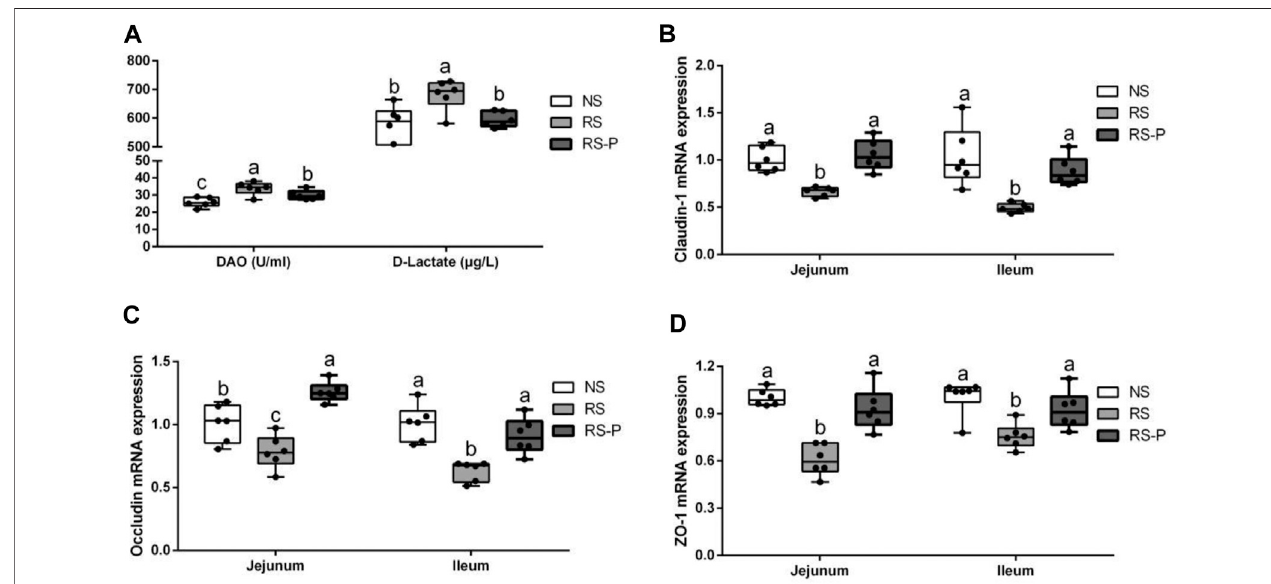
FIGURE10| EffectofL.johnsoniiBS15ongutintegrityandpermeability.Dataarepresented withthemeans ± standarddeviation( n (cid:2) 6).Barswithdifferentletters are signi fi cantly different on the basis of Duncan ’ s multiple range test ( P < 0.05). A : Levels of DAO and D-Lactate in the serum. (B) – (D) : mRNA expression levels of tight junction protein (Claudin-1, Occludin and ZO-1, respectively) in the jejunum and ileum.